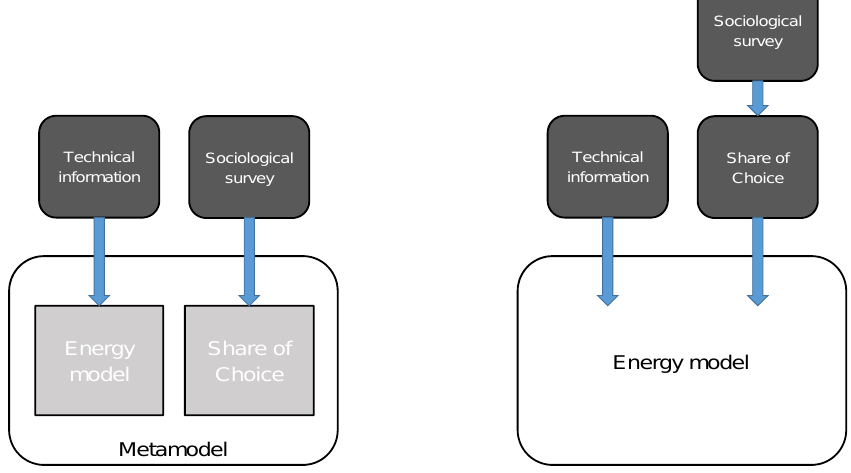
Figure 1. Coupling techno-economic energy models with behavioural approaches. On the left, the method proposed in [52]. On the right, the method proposed in the present